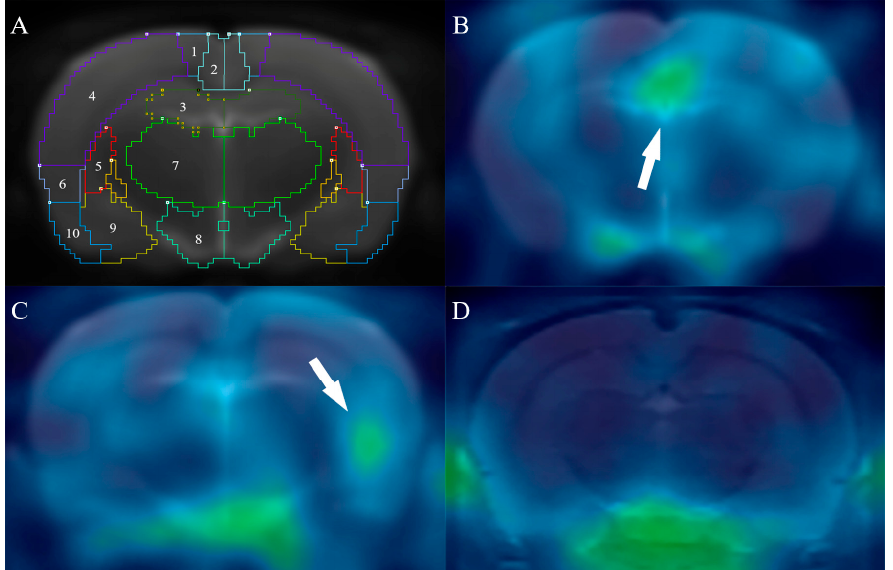
Figure 3. [ 18 F] DPA-714 uptake over the 30 min following injection in the hippocampus. Repeated measurement ANOVA showed a significant difference between the two groups. Red * indicates a significant difference in DPA-714 uptake between the two groups after this time.